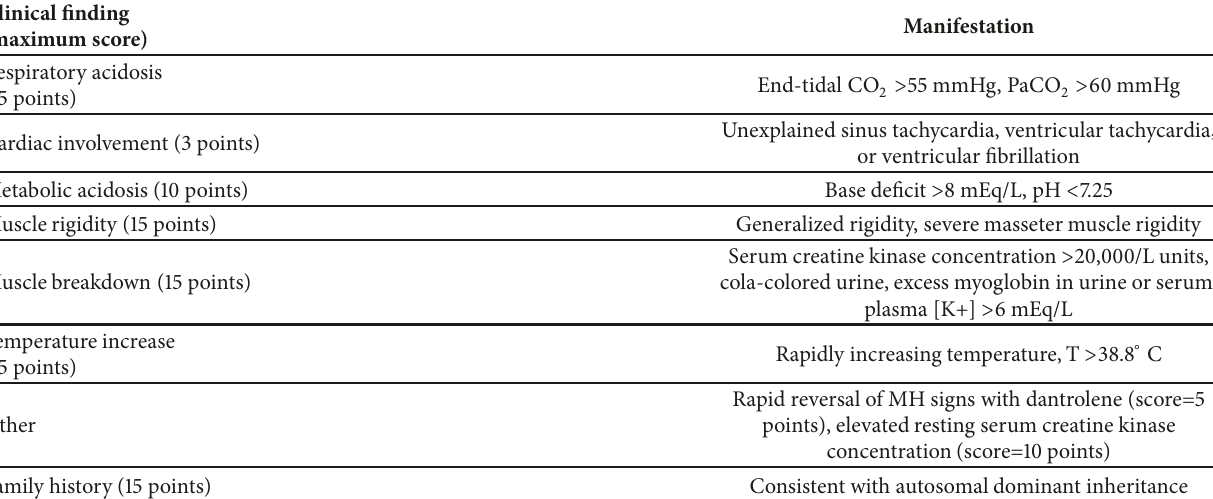
Table 4: Larach et al.’s clinical grading scale for malignant hyperthermia 1